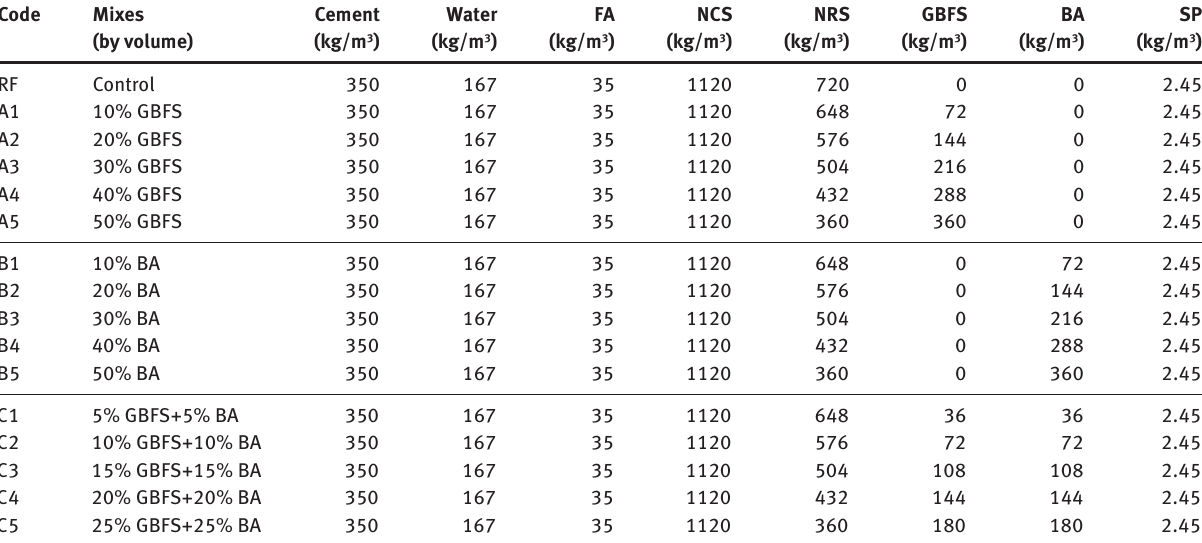
Table 8: Mixture proportions for 1 m 3 . Code